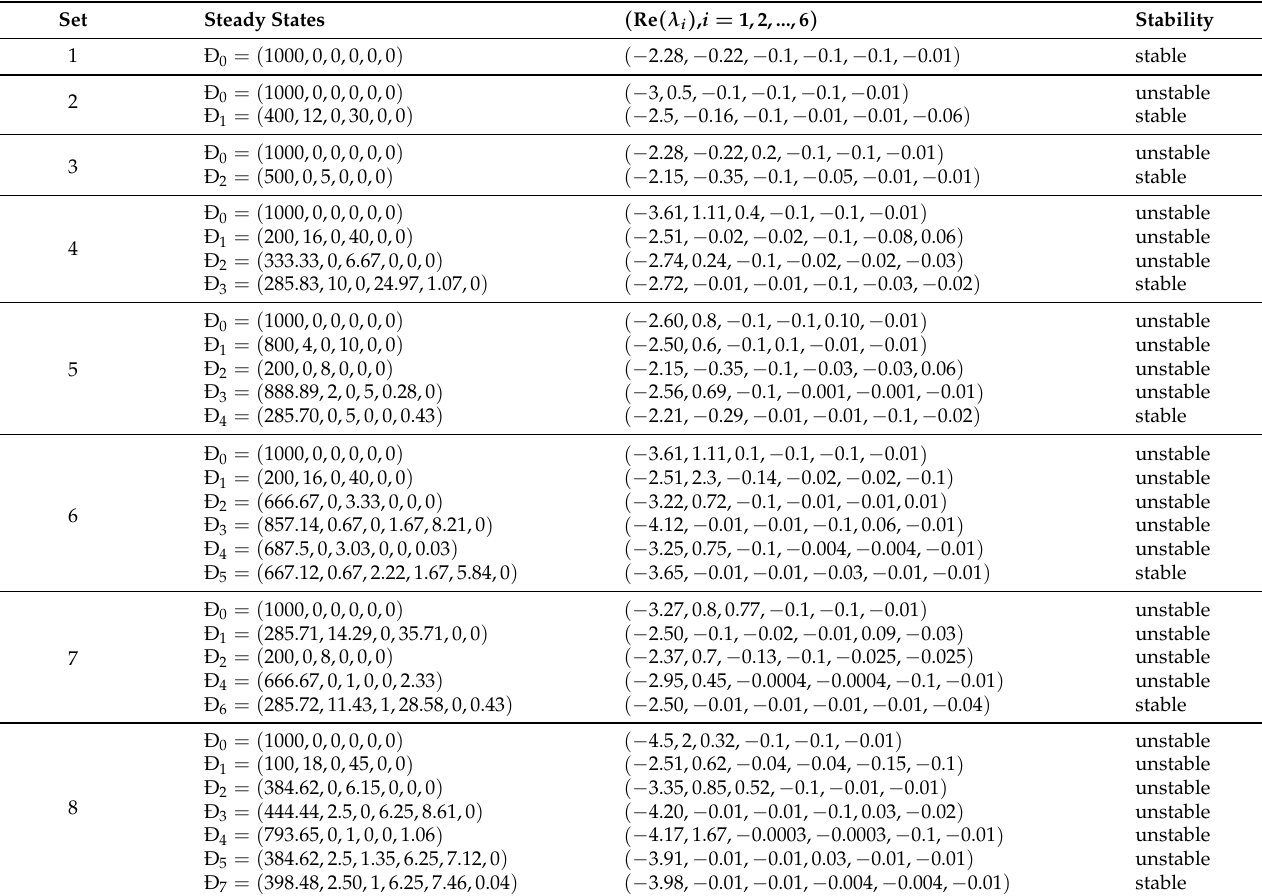
Table 4. Local stability of positive steady state Ð i , i =